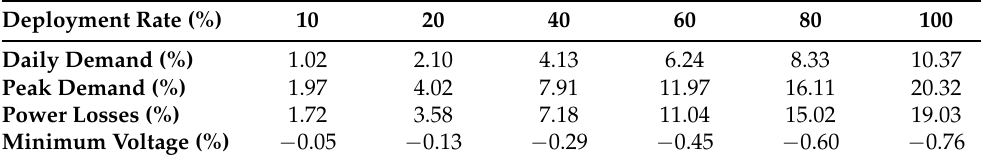
Table 5. Changes in Distribution Network